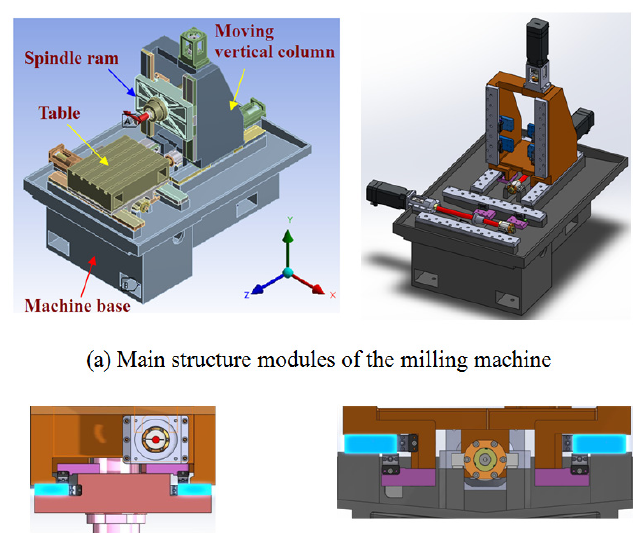
Figure 1. Schematics of a horizontal milling machine with moving column and hybrid guideways. ( a ) Main structure modules of the milling machine, ( b ) Y -axis guideway system, ( c ) X and Z -axis guideway system.